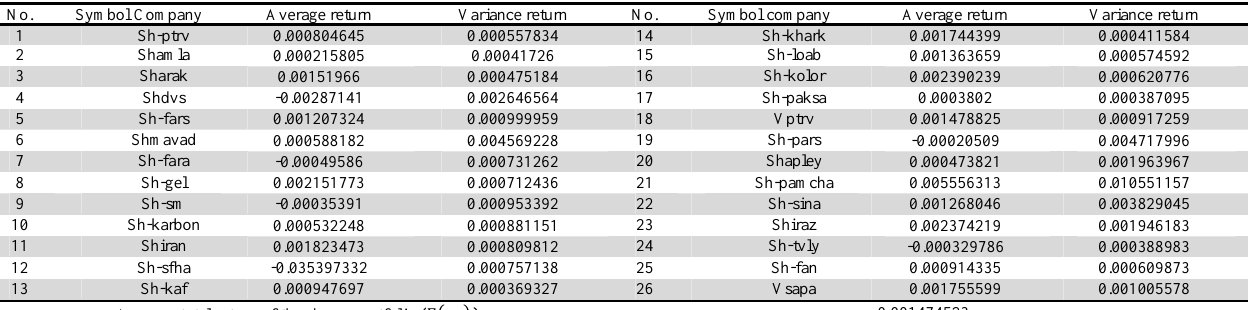
Stock Statistical